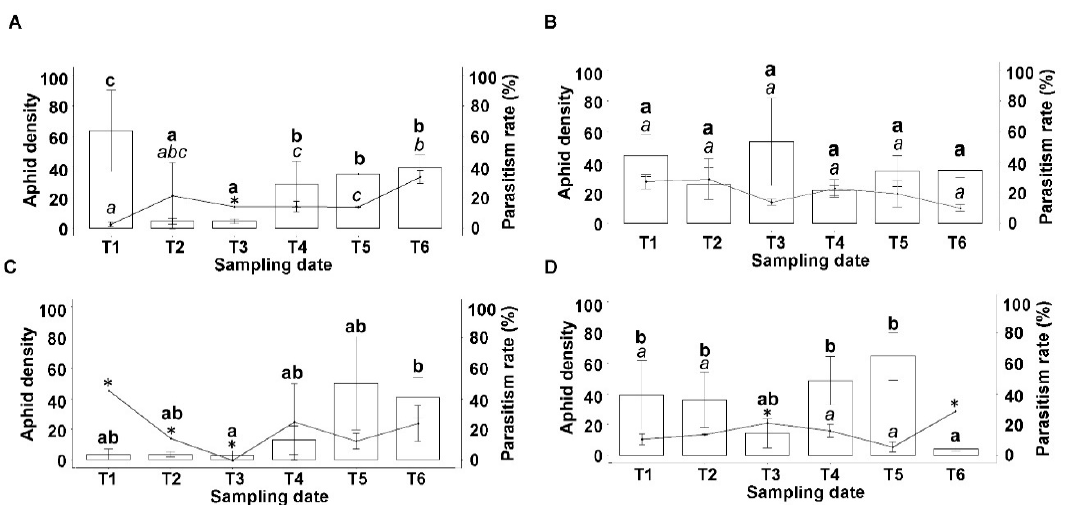
Figure 2. Aphid density (Mean ± Standard error bars) and parasitism rate (Mean ± Standard error, lines) per 100 wheat tillers in three fields sampled during the sampling dates (All fields were sampled on the same day and repeated every two weeks to complete six sampling dates T1–T6) in ( A ) Zone 1 and ( B ) Zone 2 throughout 2017; and ( C ) Zone 1 and ( D ) Zone 2 throughout 2018. Different letters show significant differences at p < 0.05 (bold letters for aphid density and italic letters for parasitism rate). * Data were obtained from one field, and hence multiple comparisons were impossible to calculate.